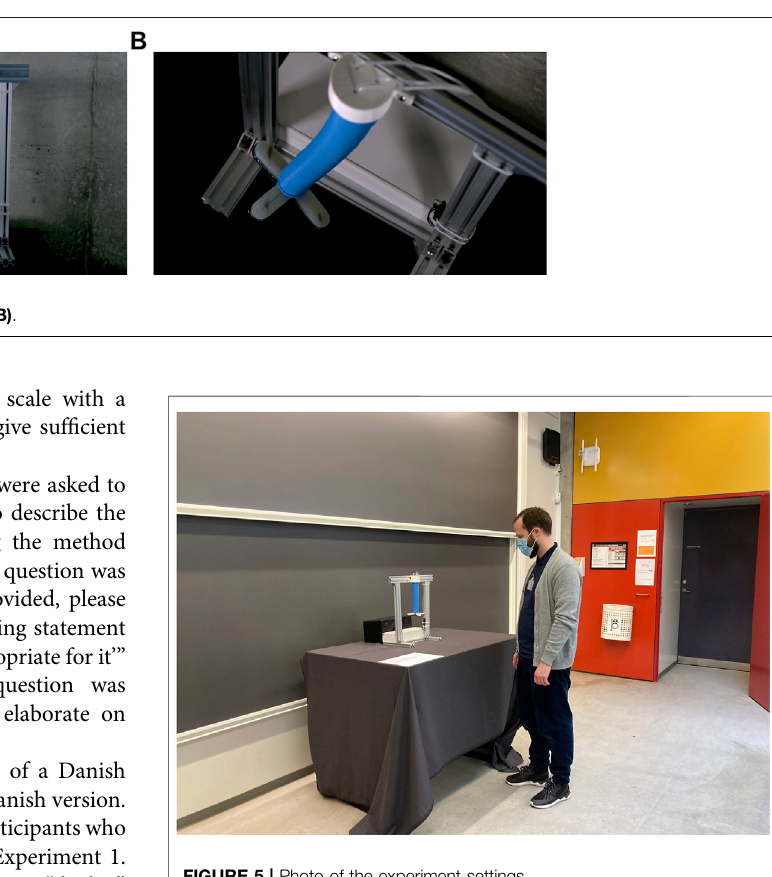
FIGURE 5 | Photo of the experiment settings.